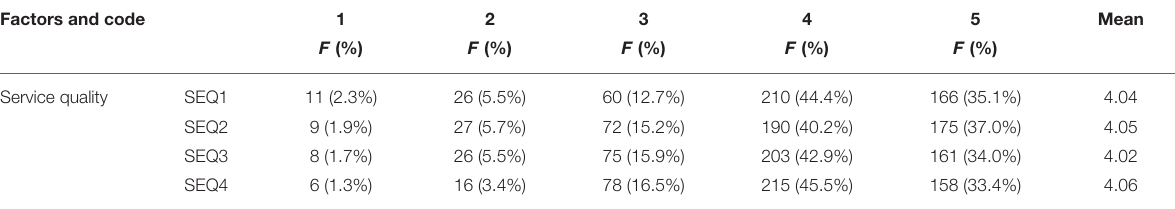
TABLE 7 | Measuring service quality (SEQ).